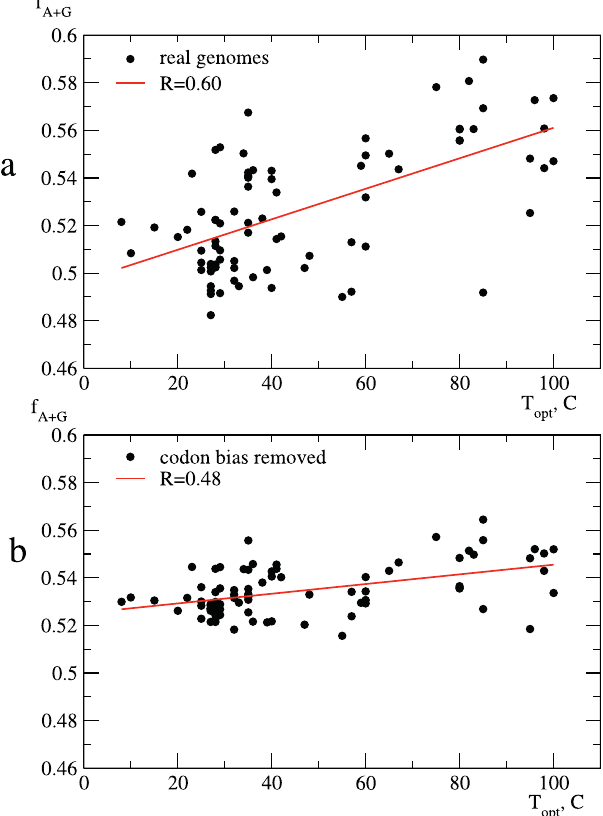
Figure 6. G þ C Content of Coding DNA Is Not Correlated with OGT or IVYWREL (A) Dependence of the fraction of IVYWREL amino acids in 83 proteomes (protein thermostability predictor) on the fraction of G þ C in the coding DNA in the corresponding genomes. (B) Dependence of the G þ C content in the coding DNA of the 83 complete genomes on the OGT of the organisms. The correlation coefficient is R ¼(cid:2) 0.15, indicating that G þ C content of the coding DNA is not related to the OGT.